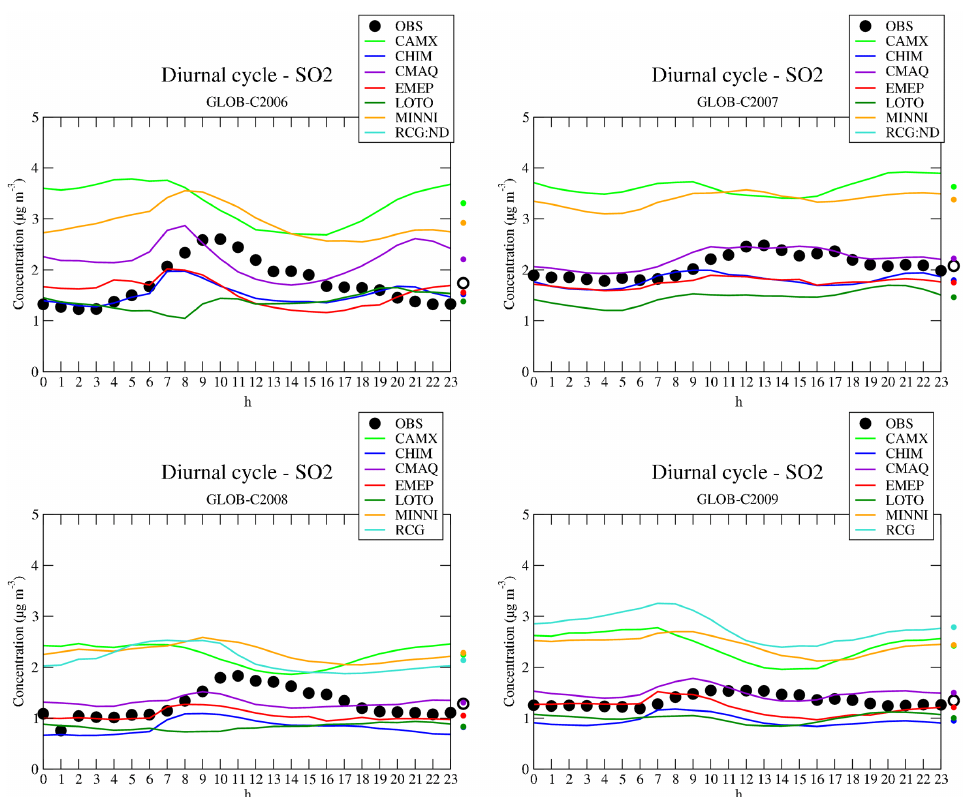
Figure 11. Mean SO 2 diurnal cycles for all campaigns simulated by the models compared with observations. Averaged concentrations are provided on the right side of the charts.